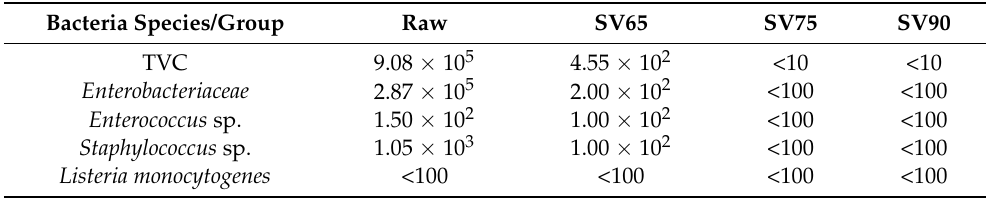
Table 4. The effect of sous vide parameters on microbial quality of pikeperch fillets (the number of bacteria is expressed in